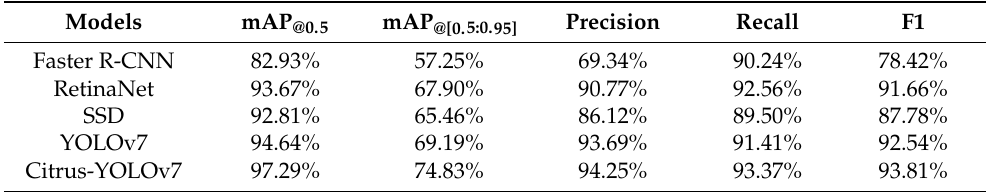
Table 2. Model performance table under multiple indicators. Models